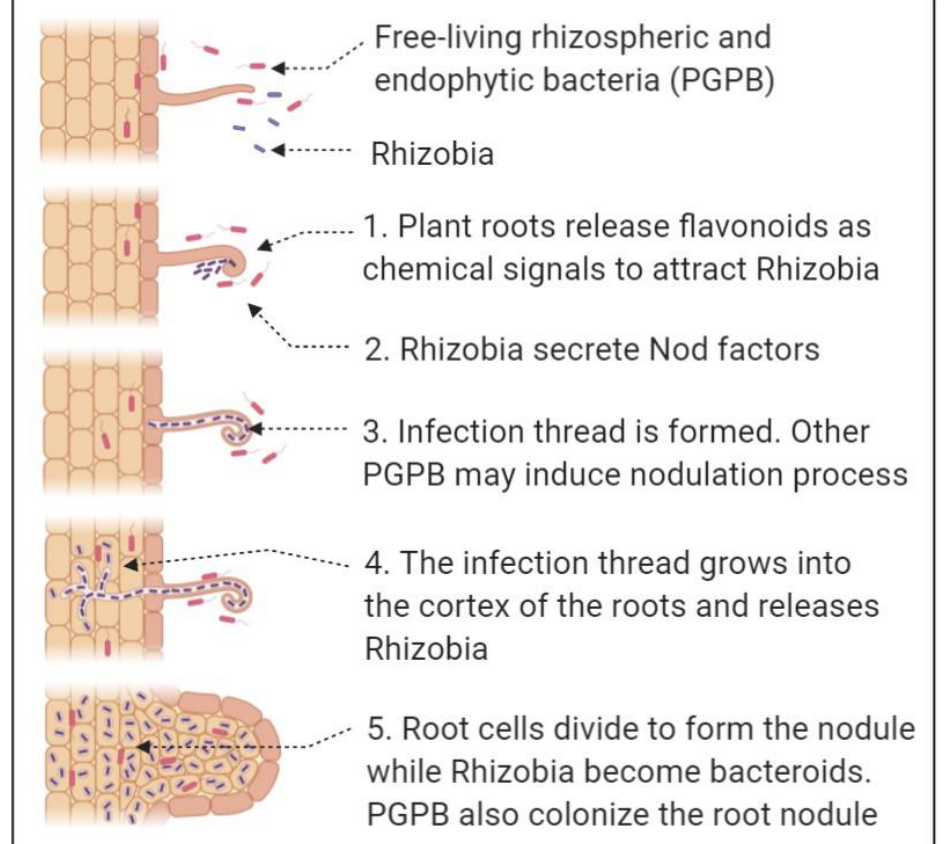
Figure 3. The formation of N-fixing nodules induced by rhizobia. Free-living plant-growth-promoting rhizobacteria and bacterial endophytes may induce the nodulation process and increase the nitrogen fixation, general plant growth, and nutrimental state.